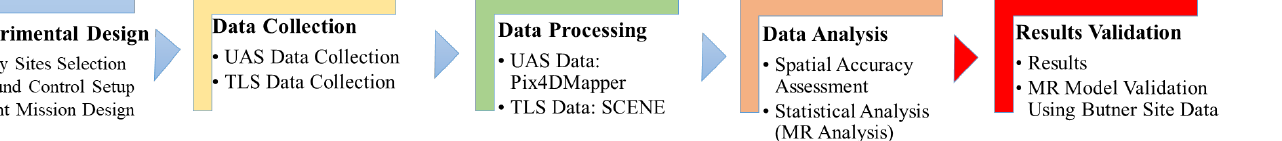
Figure 1. Workflow of Research Process: Methodology and Results Validation.